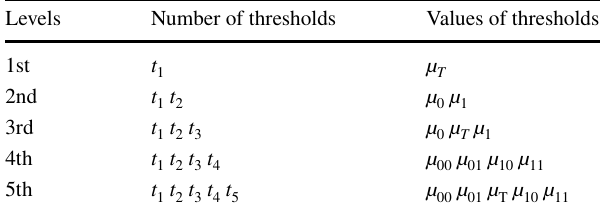
Table 1 Number and values of thresholds with center of gravity